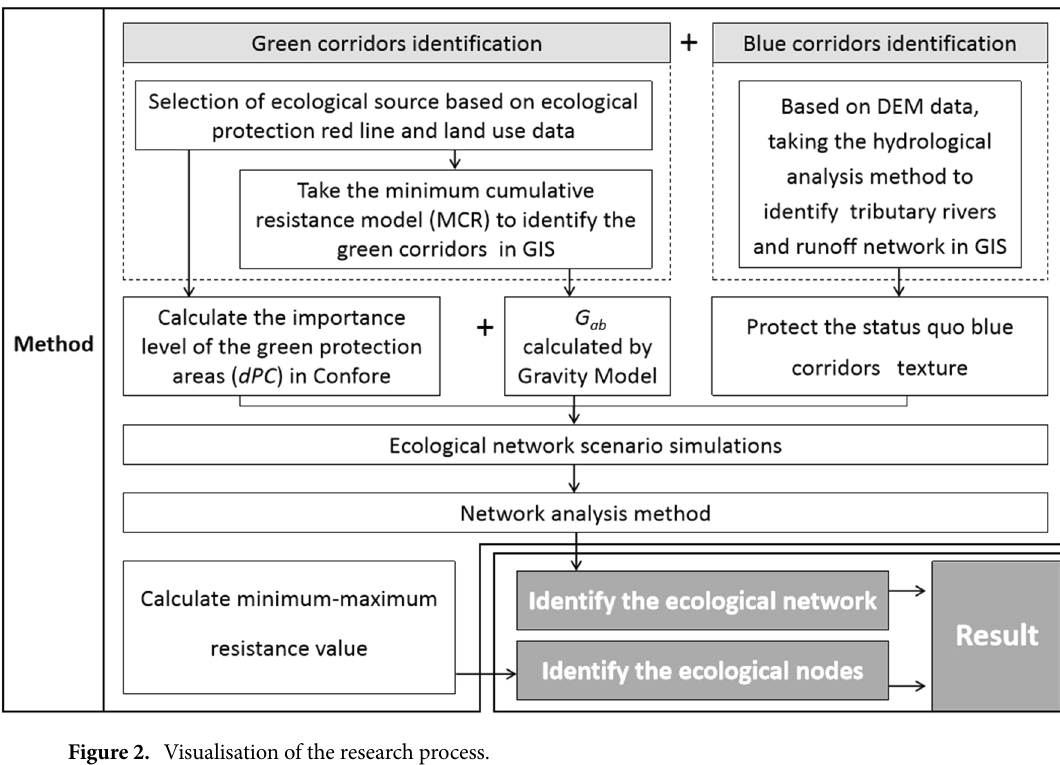
Figure 2. Visualisation of the research